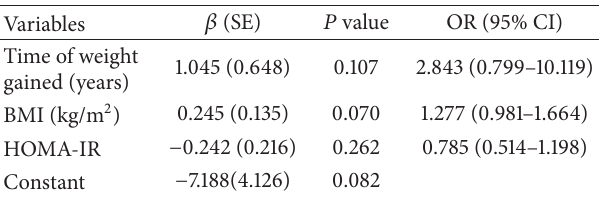
Table 9: Model for predicting abnormal mixed nerve function (Model 5).